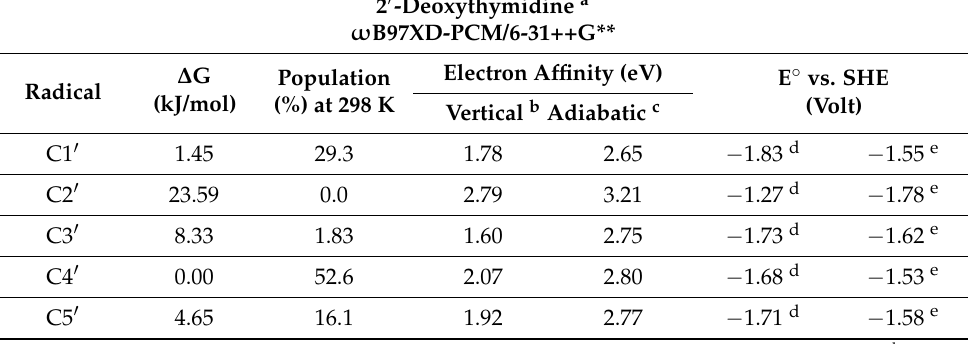
Table 2. The ω B97XD-PCM/6-31++G**-calculated relative free energies ( ∆ G), relative populations based on Boltzmann distribution, electron affinities, and one-electron reduction potential of sugar radicals of 2 (cid:48) -dT.